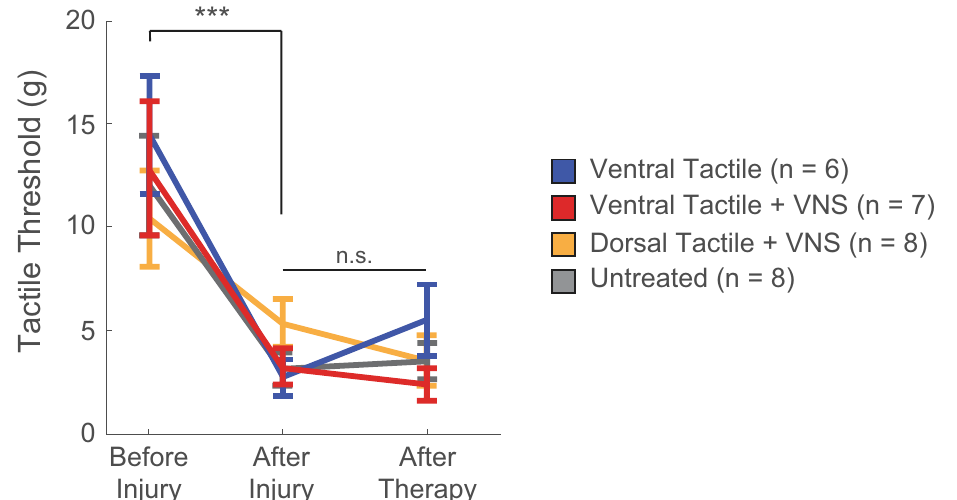
Figure 1. VNS paired with tactile rehabilitation fails to improve forelimb withdrawal thresholds. Radial nerve injury produces lasting allodynia in the forelimb, as demonstrated by sustained reductions in forelimb withdrawal thresholds. VNS paired with tactile therapy, consisting of mechanical stimulation of either the dorsal (Dorsal Tactile + VNS, n = 8) or ventral (Ventral Tactile + VNS, n = 7) surface of the forepaw, fails to improve withdrawal thresholds compared to tactile therapy without VNS (Ventral Tactile, n = 6) or no therapy (Untreated, n = 8). Data presented as mean ± SEM. *** denotes p < 0.001 at the indicated timepoints; n.s. denotes not significant group